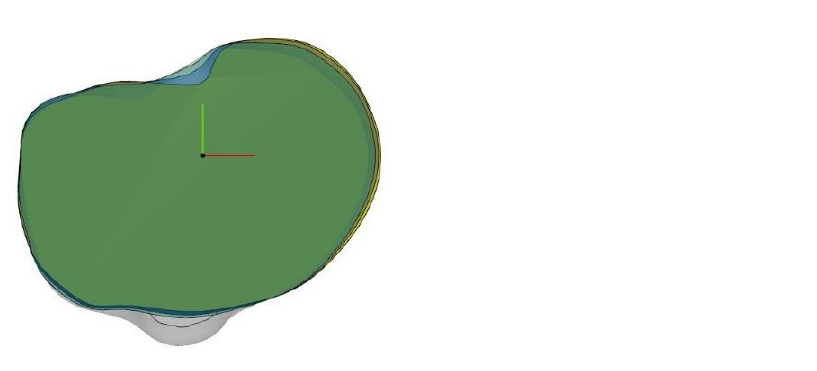
Figure 5. AP/ML dimensions on the Caucasian and Asian population, the SSM and the 10 addition- ally generated statistical models .